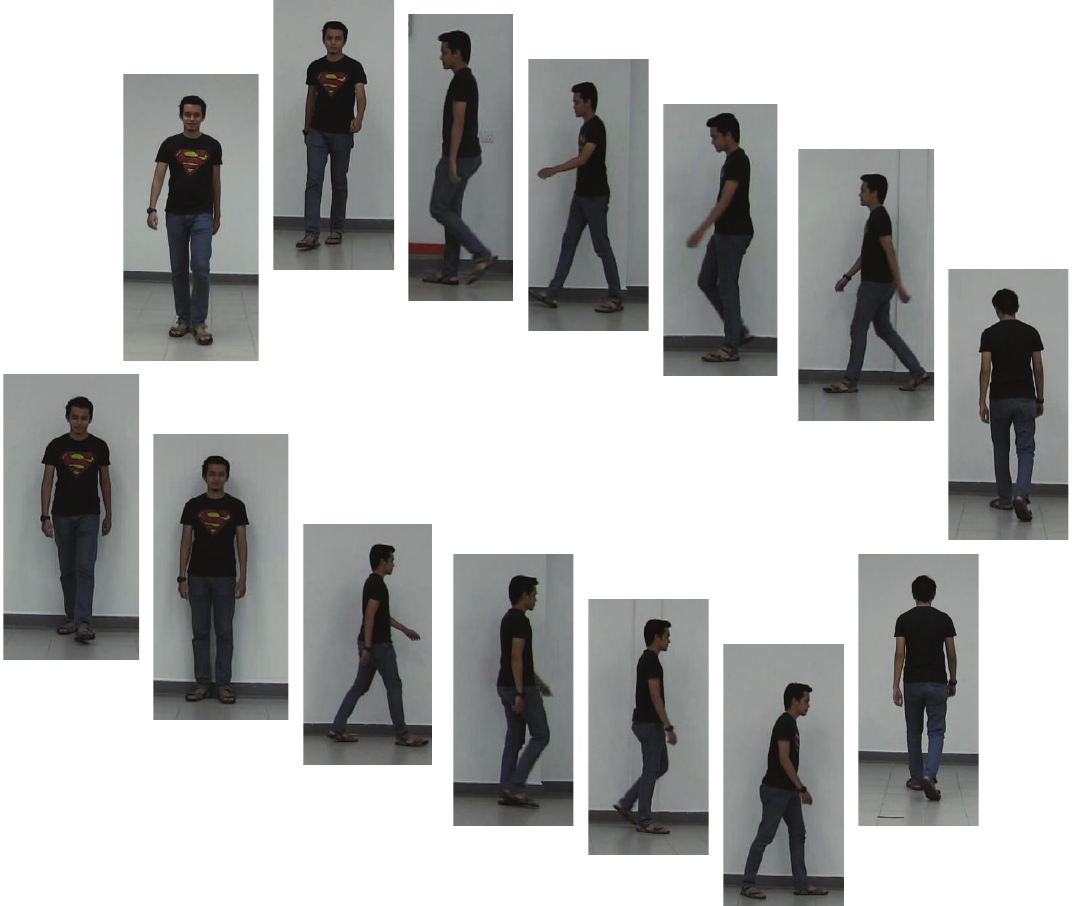
Figure 9: Fourteen frame sets of a subject selected at 1fps showing four different poses.